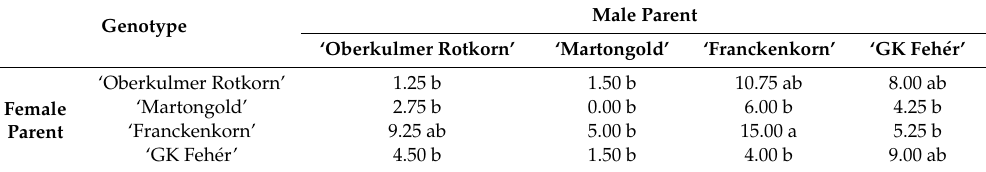
Table 3. Mean of albinos in anther culture of a full diallel spelt wheat population. Values with the same capital letters are not significantly di ff erent ( p > 0.05).